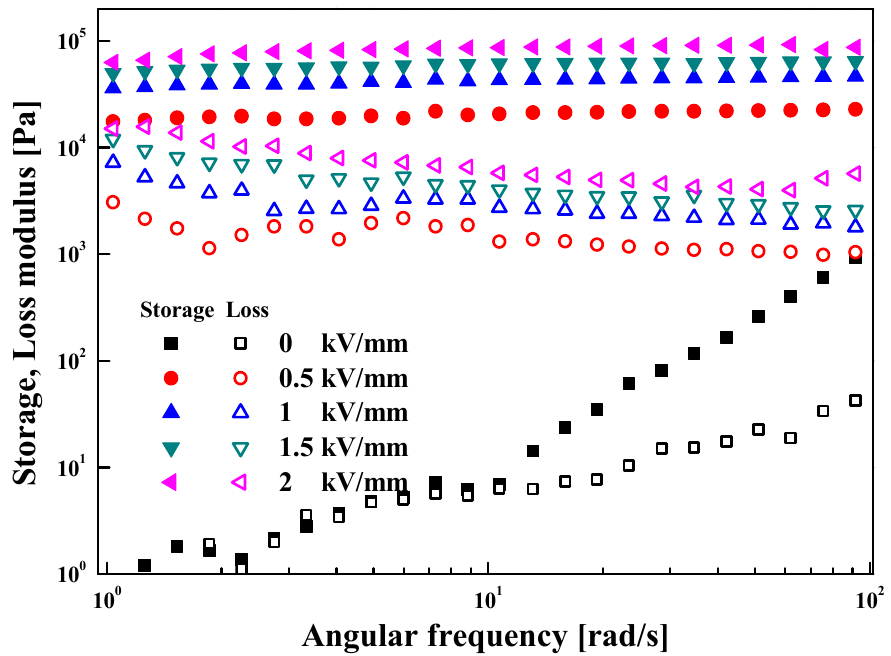
Figure 8. G (cid:48) (closed) and G (cid:48)(cid:48) (open) for the core–shell Fe 3 O 4 /POA particle-based ER suspension Figure 8. G ′ (closed) and G ″ (open) for the core–shell Fe 3 O 4 /POA particle-based ER suspension under various E s as a function of angular under various E s as a function of angular frequency.